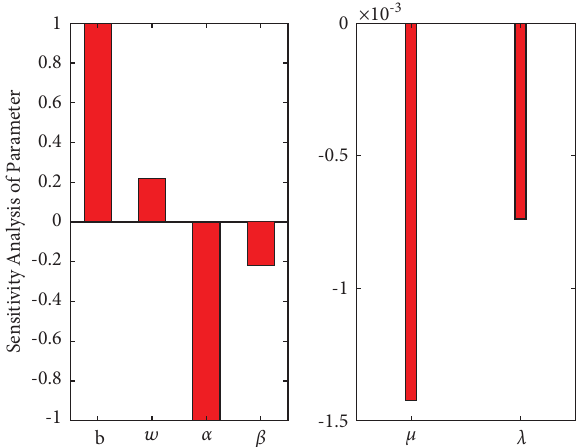
Figure 2: Te dynamics of sensitivity analysis based on R respect to each parameter associated with R